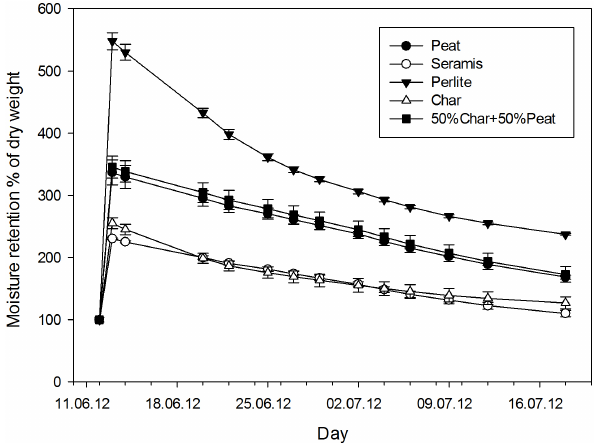
Figure 2. Moisture uptake and drying of different growing media (peat, clay granules, perlite, biochar, and biochar mixed with peat, n = 3, error bars: standard deviation).